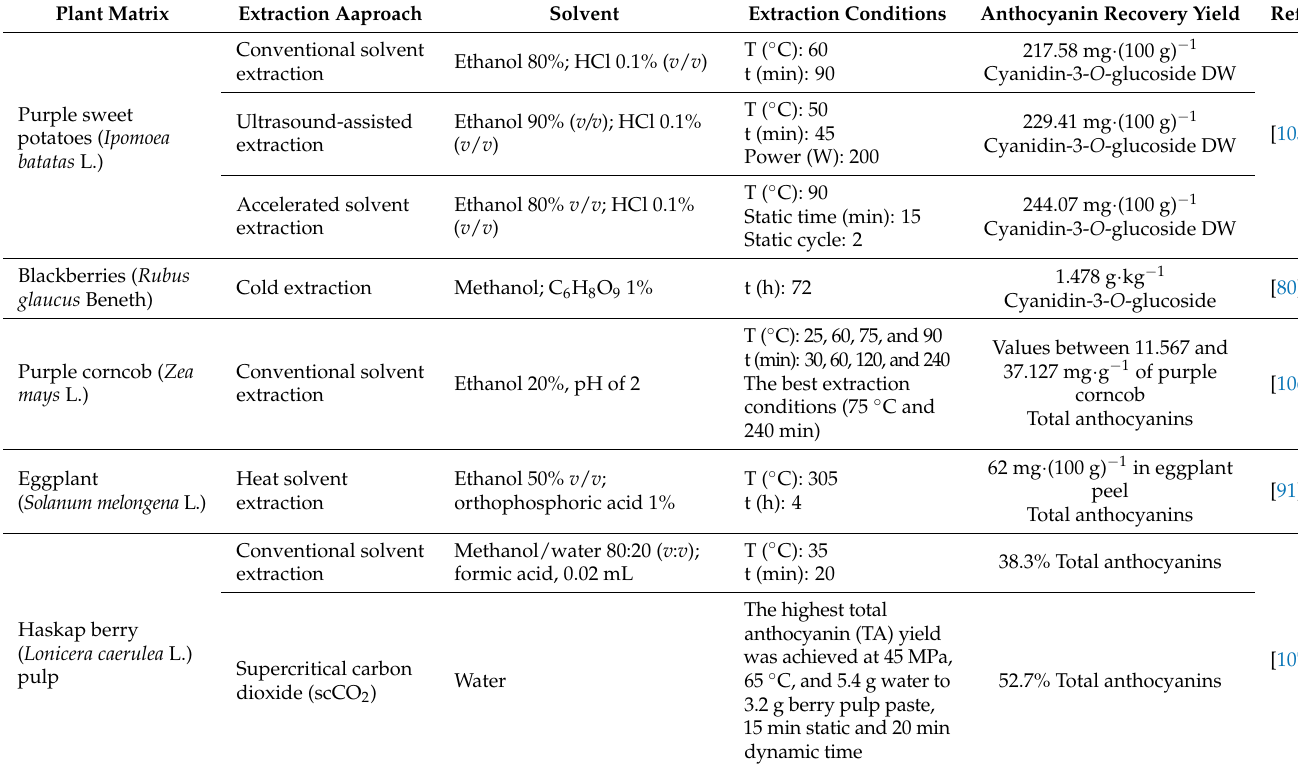
Table 2. Comparison of different methods employed for anthocyanin